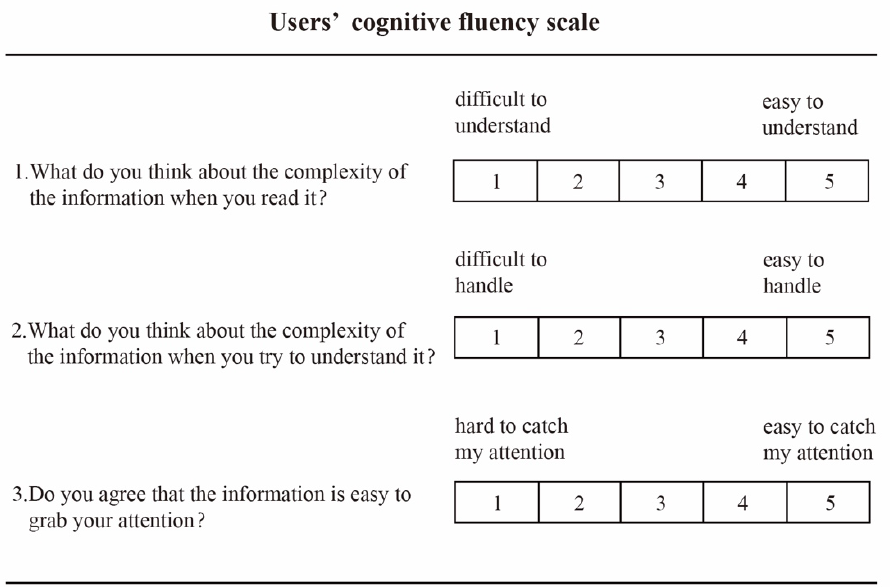
Figure A1. User cognitive fluency scale.